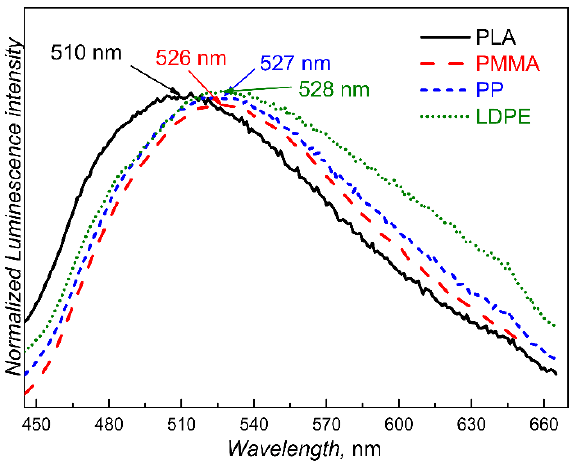
Figure 2. Normalised PL emission spectra of samples of PTMSDPA-labelled polymer compounds prepared in the first processing cycle. Each PL emission spectrum was recorded using an excitation wavelength individually set to the maximum of the excitation spectrum of the respective compound.